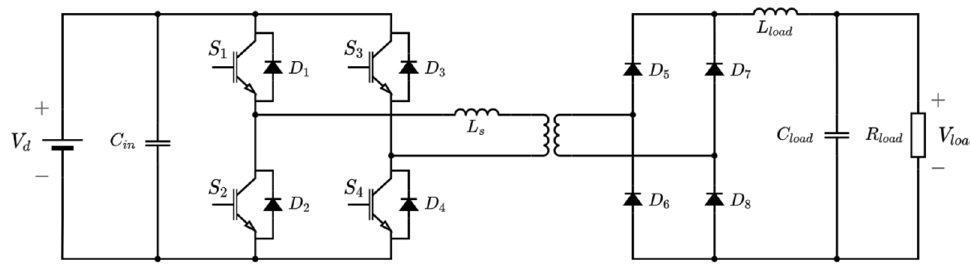
Figure 16. Isolated full-bridge DC/DC converter. A simpler version of the full-bridge converter is the half-bridge converter in Figure 17. The half-bridge converter only has two switches (here, IGBTs), and the two other switches are replaced with large-value capacitors. The voltage over the primary side of the trans- former is half of that of the full-bridge converter. This means that, for a given power level, the switches must be able to handle twice-as-large currents. Therefore, the half-bridge converter is usually suitable for lower power levels than the full-bridge converter